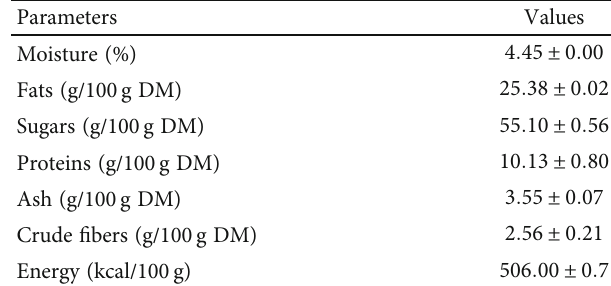
Table 6: Proximate composition of the optimized